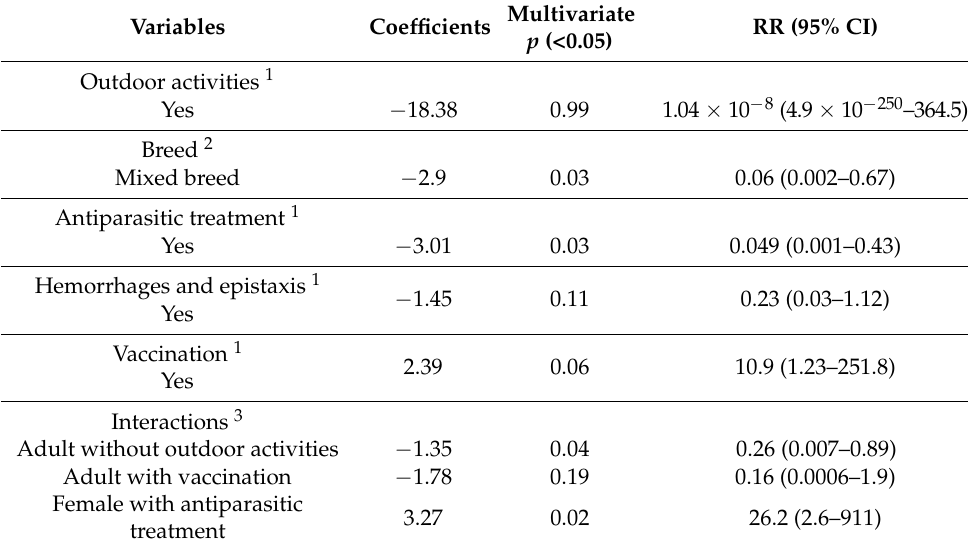
Table 2. Results of the multivariate stratified analysis to identify the association between exposure and clinical variables with the occurrence of the typhus group (TG) Rickettsia infection in domiciliated dogs from Maxcan ú , Yucatan,